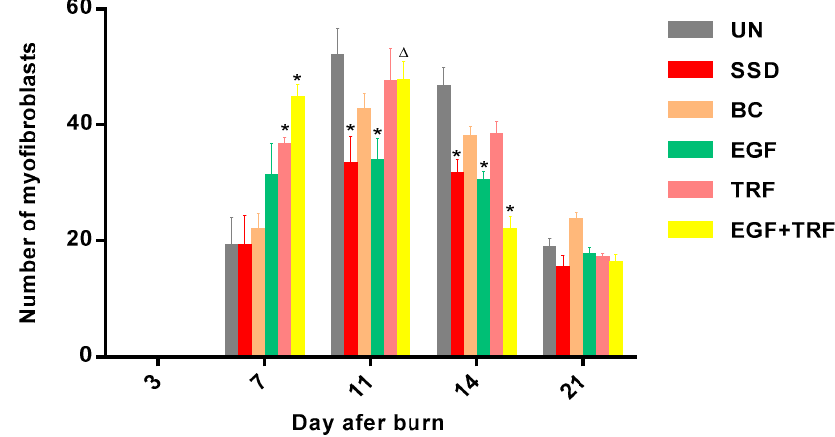
Figure 6. The number of myofibroblasts in all the groups over time post-burn. Note: Values calculated over a 21-day trial and expressed as mean ± S.E.M. for six rats. * p < 0.05 compared with those of the UN group on the respective day and ∆ p < 0.05 compared with those of the SSD group on the respective day.